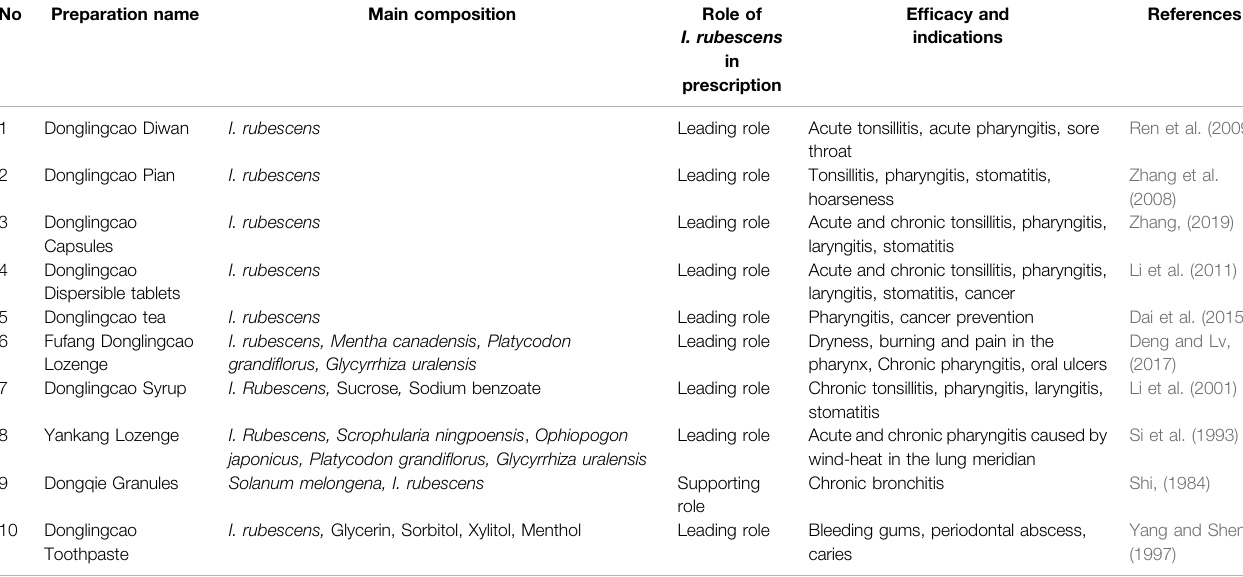
TABLE 1 | The prescriptions and ef fi cacy indications of I. rubescens in